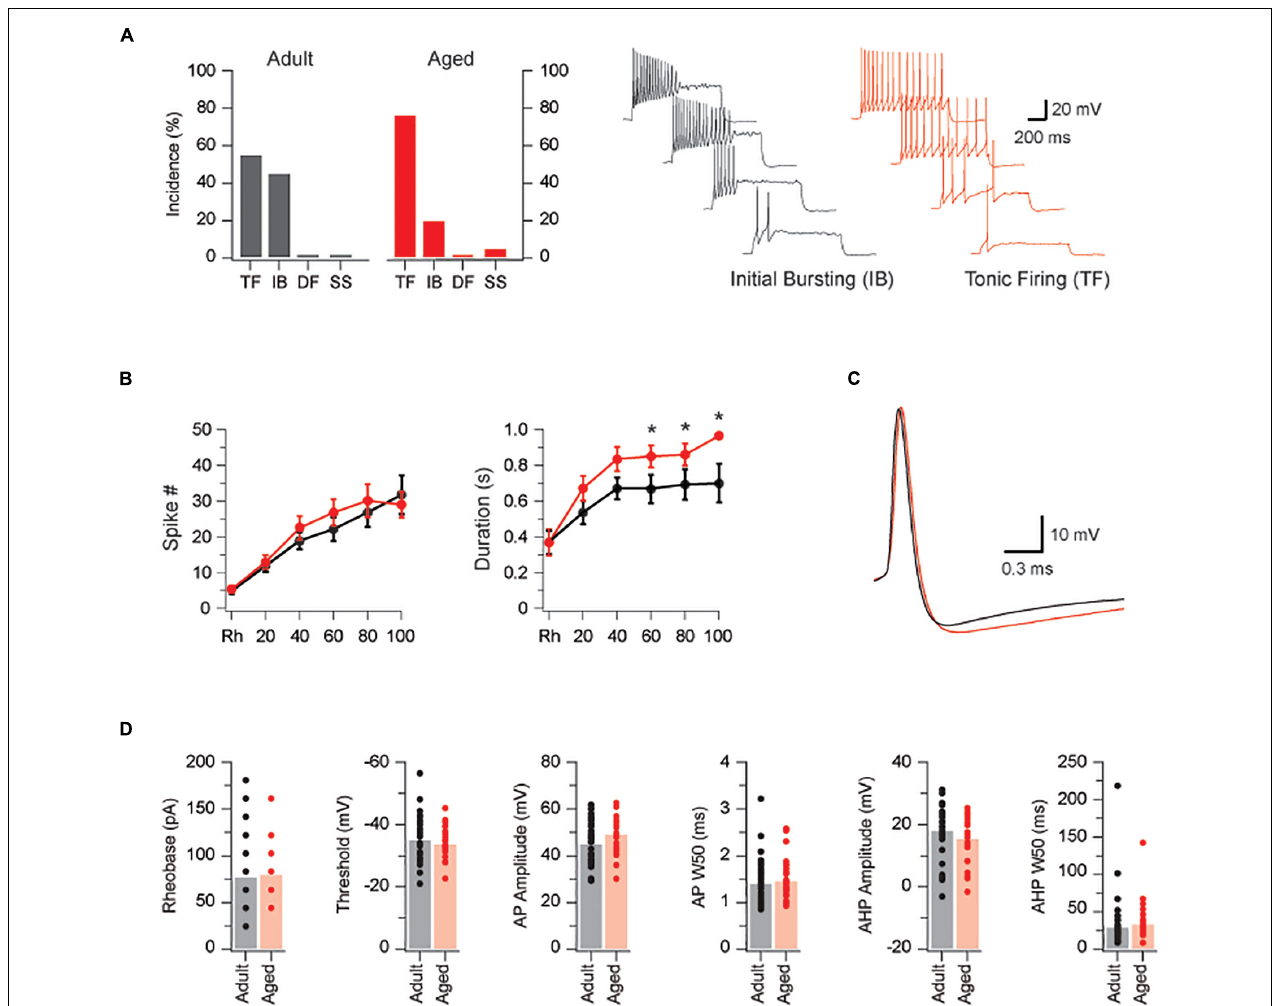
FIGURE 1 | PVINs are more excitable in aged mice. (A) Bar graphs compare the incidence of AP discharge patterns in adult (black bars) and aged PVINs (red bars). TF and IB discharge dominate at both ages but there is a shift from IB to TF discharge in aged mice. Traces show the Initial Bursting and Tonic Firing AP discharge patterns in PVINs during depolarizing current step injections (20 pA step increments, 1 s duration). (B) Current-frequency and current-discharge duration relationships in adult (black dots) and aged (red dots) mice for five depolarizing current steps above rheobase. Note, AP discharge duration is enhanced in the aged population. (C) Overlaid traces of representative AP’s from adult (black) and aged (red) PVINs. (D) Group data comparing AP properties in adult (black) and aged (red) PVINs. None of the six AP properties (rheobase, threshold, AP amplitude, AP halfwidth – APW50, AHP amplitude, and AHP half-width – AHPW50) differed in adult and aged PVINs. * p <